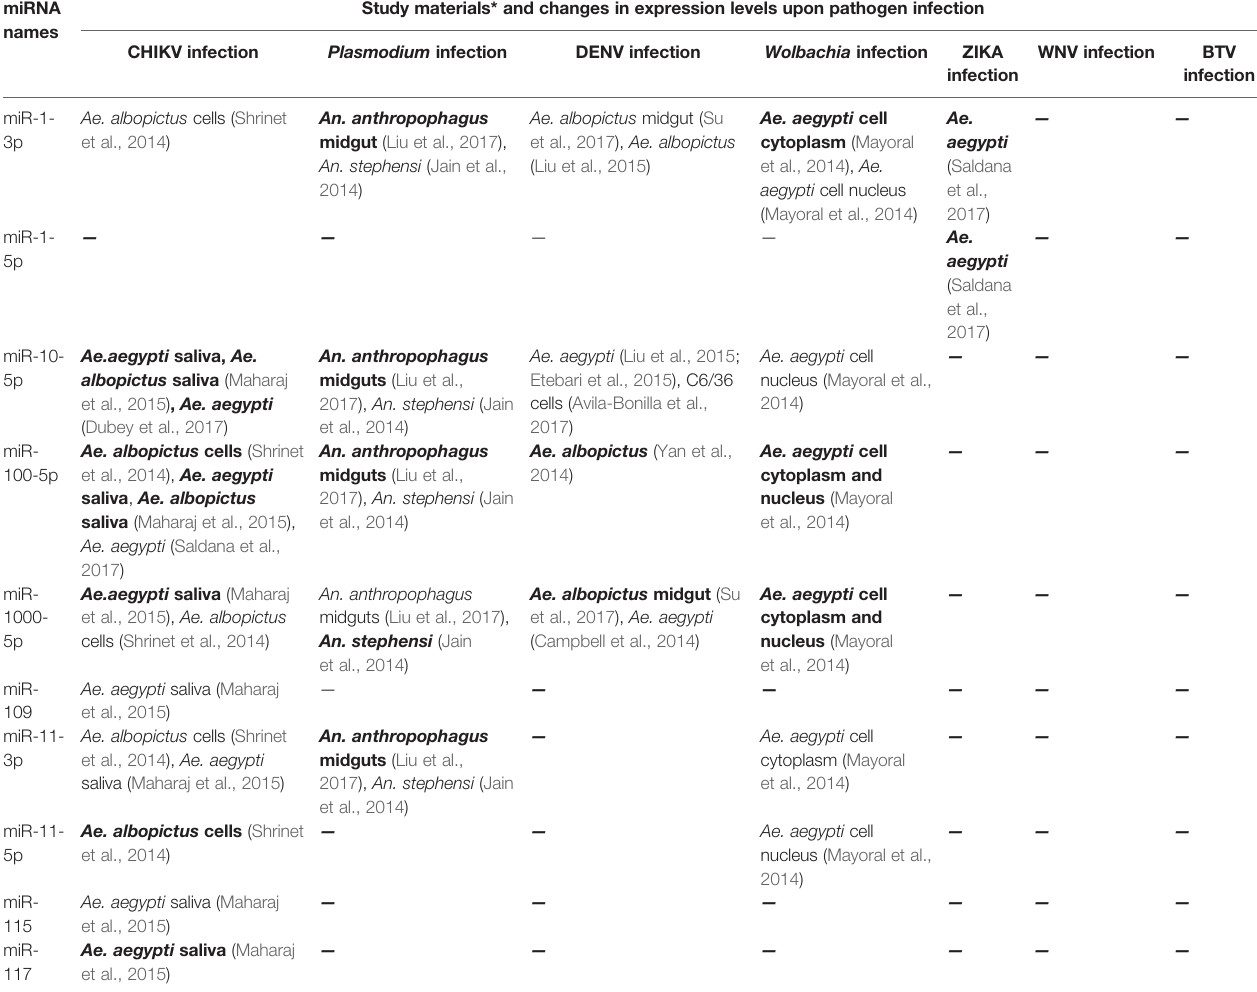
TABLE 6 | Alterations in miRNA abundance in response to infection with different pathogens in various mosquito